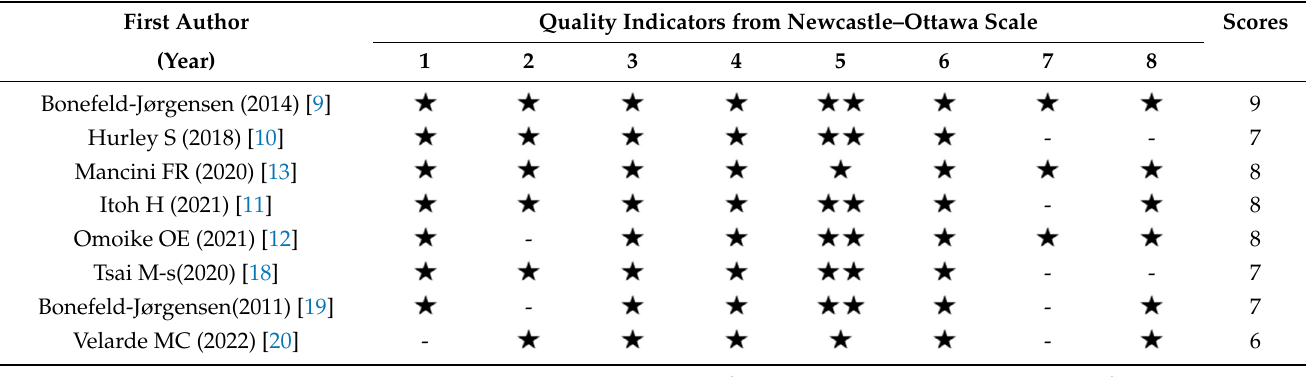
Table 2. Newcastle–Ottawa quality assessment scale.